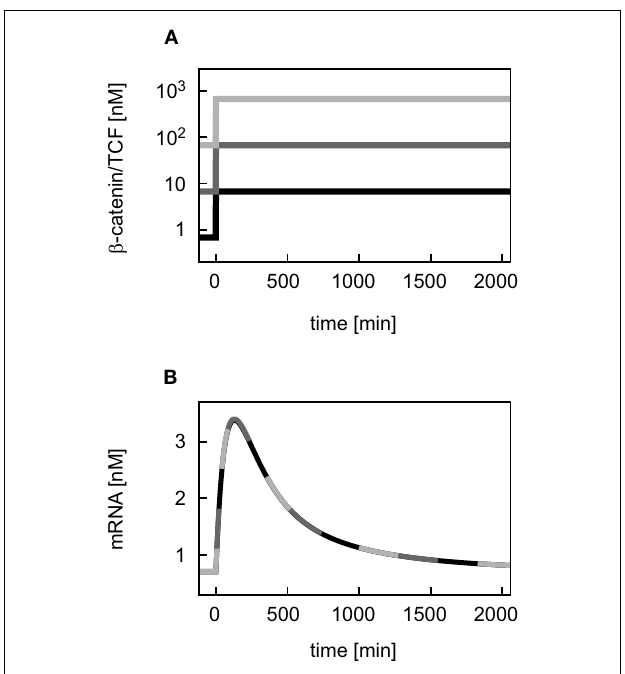
FIGUREA1 | Input ( β -catenin/TCF) and output (mRNA) time courses of the iFFL motif. (A) A stepwise increase of the β -catenin/TCF concentration leads to (B) a perfect adaptation of the target gene mRNA.The dynamics of the mRNA is independent of the initial absolute concentration of β -catenin/TCF if the same fold change in the β -catenin/TCF level is induced.